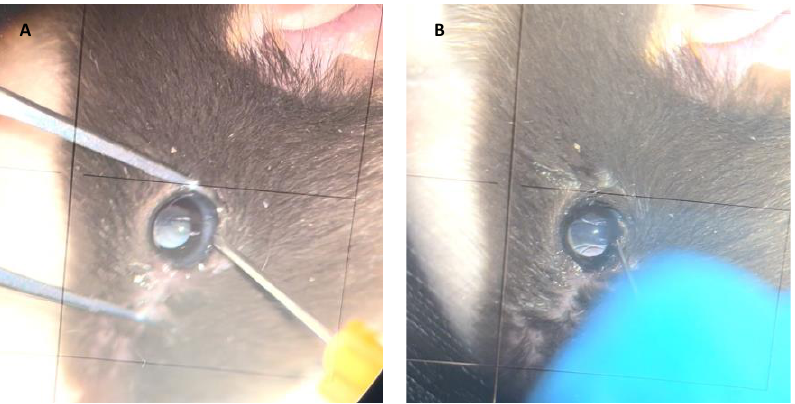
Figure 4. Subretinal injection technique in animal models. Anterior transscleral approach. ( A ) A retinotomy is performed in the limbus. ( B ) A blunted cannula used for subretinal injection.